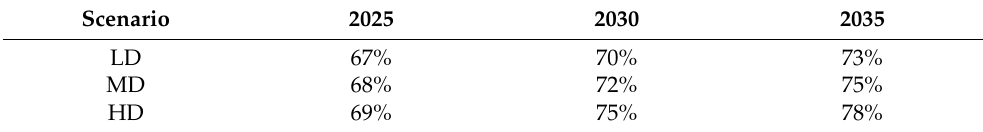
Table 2. The urbanization rate of Shandong Province under different scenarios from 2020 to 2035.